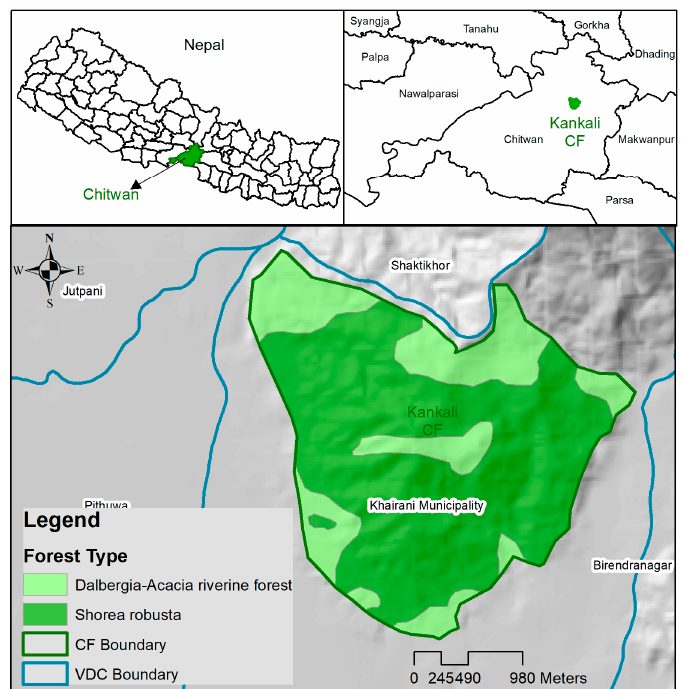
Figure 1. Study area in central Nepal showing different forest types and Village Development Committee boundary.